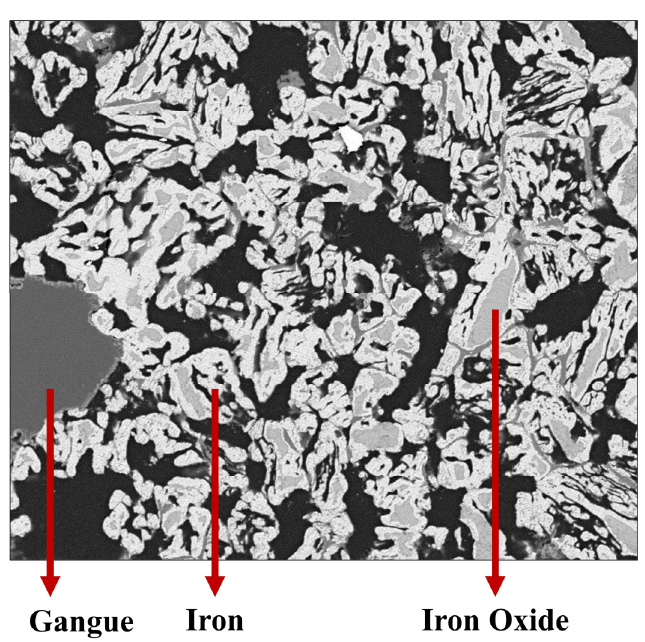
Figure A1. Phase comparison of SEM image showing iron oxide, gangue and iron.